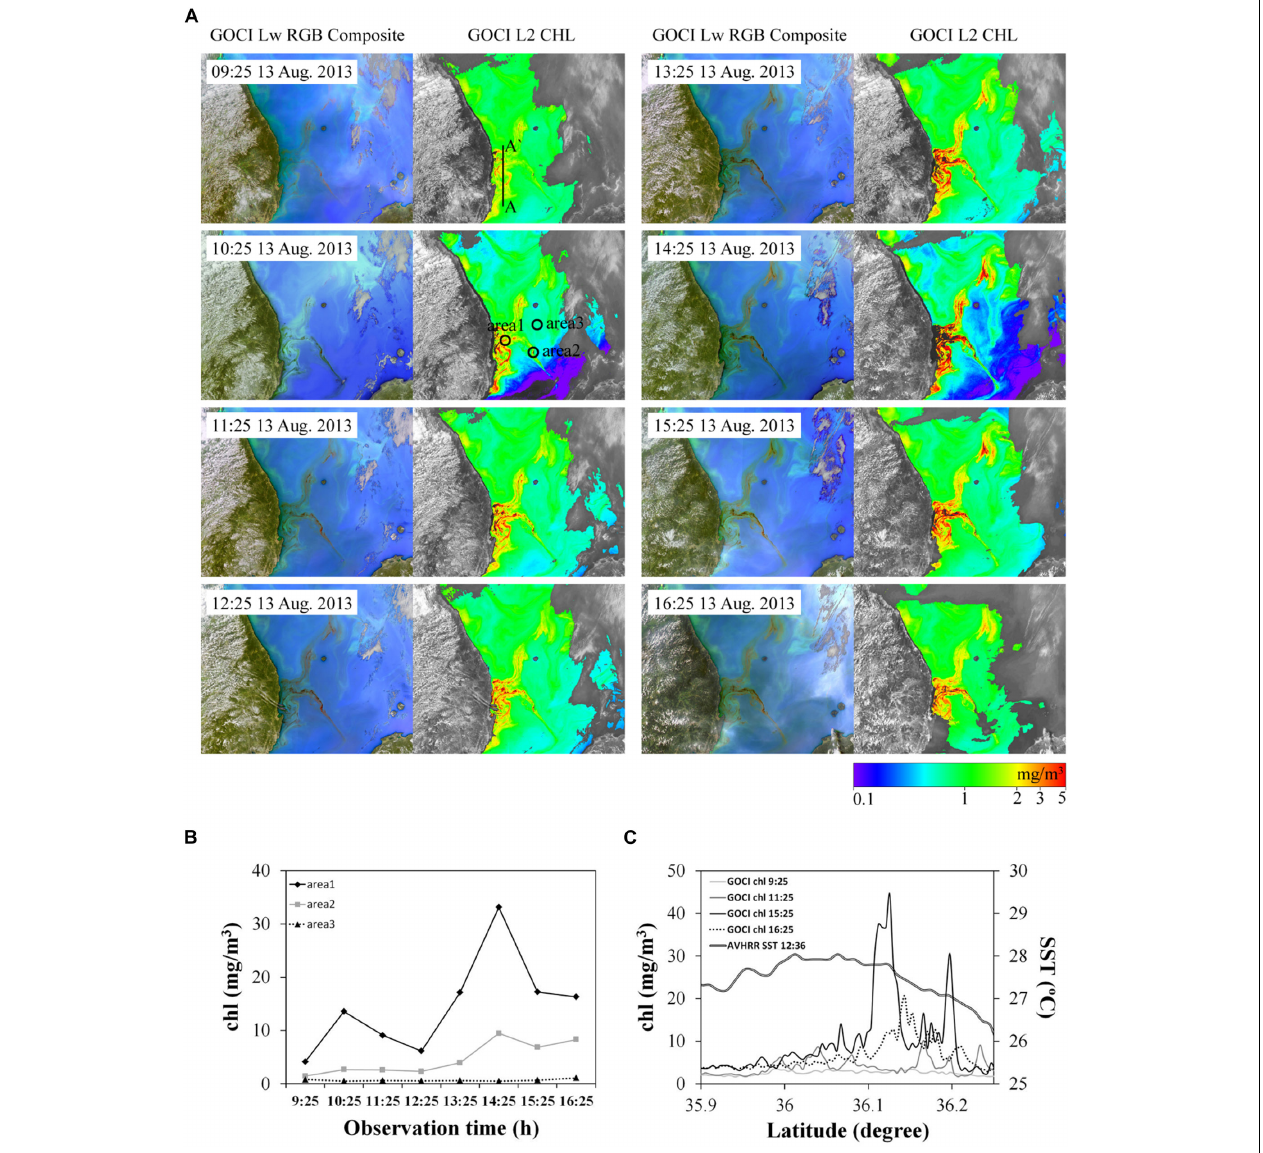
FIGURE 7 | (A) Geostationary Ocean Colour Imager radiance composite images and corresponding chl-a images from 09:25 to 16:25 on 13 August 2013: the chl-a profile line (AA (cid:48) ) and the hourly chl-a investigation points (1–3) are marked; (B) Hourly GOCI chl-a values at points 1–3; and (C) chl-a values along line AA (cid:48) at 09:25, 11:25, 15:25, and 16:25 local